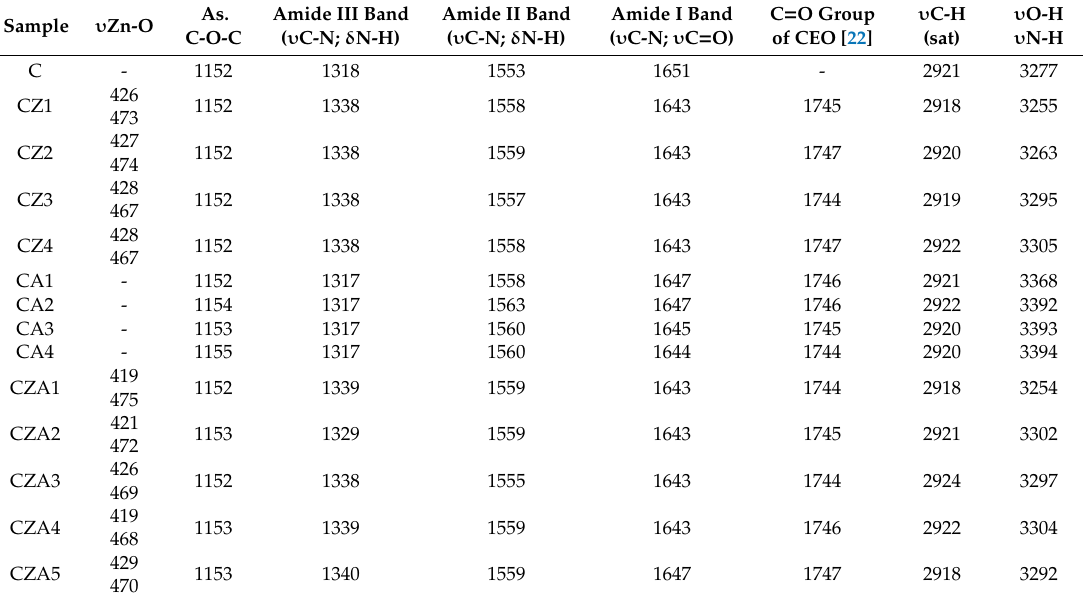
Table 2. Assignment of relevant IR absorption bands of chitosan control and chitosan / NPs / CEO films.